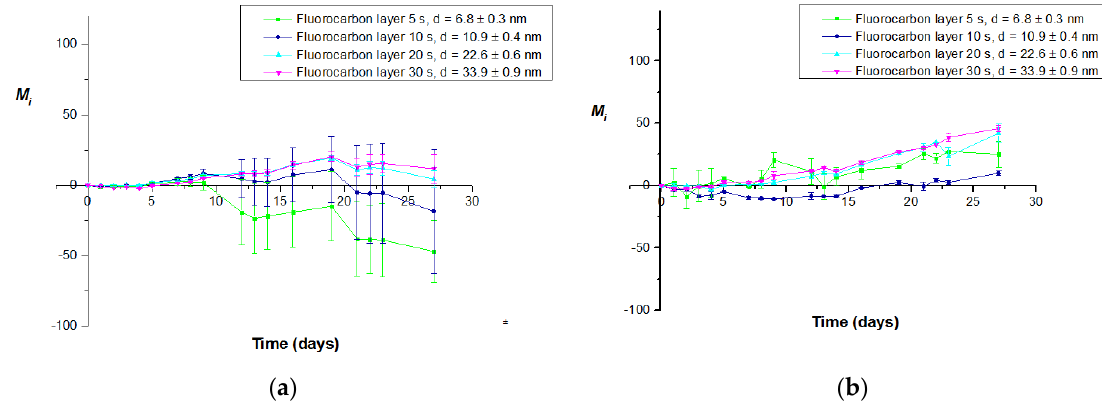
Figure 5. Antibacterial activity of copper-enriched ( a ) hydrophobic and ( b ) micro-nanotextured superhydrophobic PMMA surfaces coated with fluorocarbon layer from C 4 F 8 gas discharge for varying deposition times of 5, 10, 20, and 30 s alongside with the analogous coating thickness d. For the hydrophobic surfaces, optimal antibacterial activity is observed for fluorocarbon layer deposition of 5 and 10 s (6.8 and 10.9 nm thickness, respectively), and is reduced for longer deposition times. For the superhydrophobic surfaces, 5 s deposition is not enough to cover the surface roughness, thus 10 s deposition gives the optimal behavior, combining superhydrophobicity with optimum copper diffusion for the bactericidal activity.